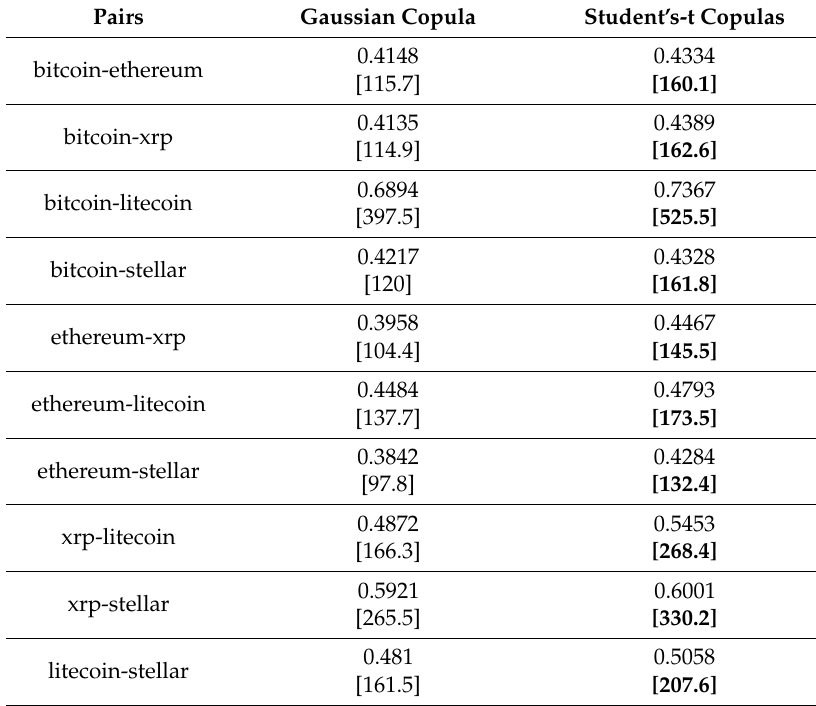
Table 7. Gaussian Copula and Student’s ‐ t Copulas estimation.